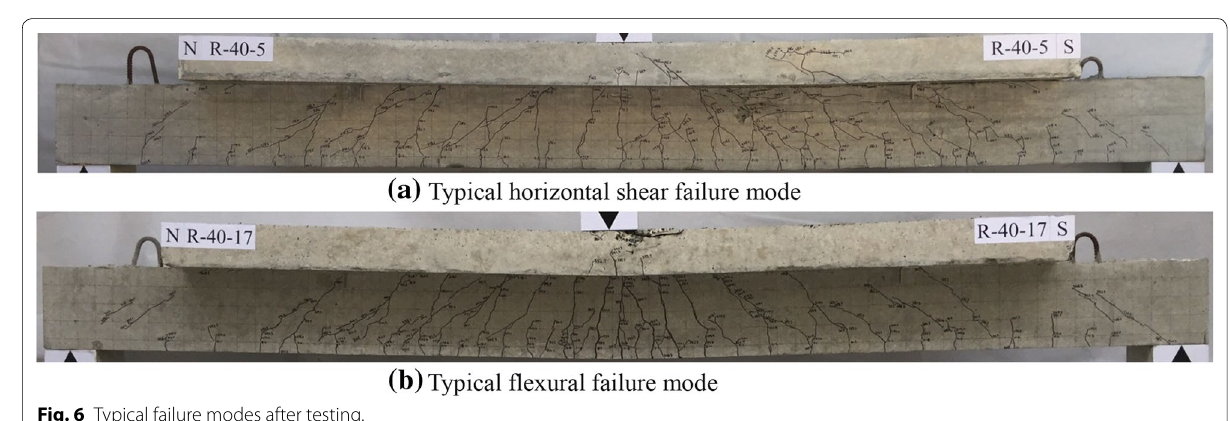
Fig. 5 Schematic diagram of horizontal shear failure modes.